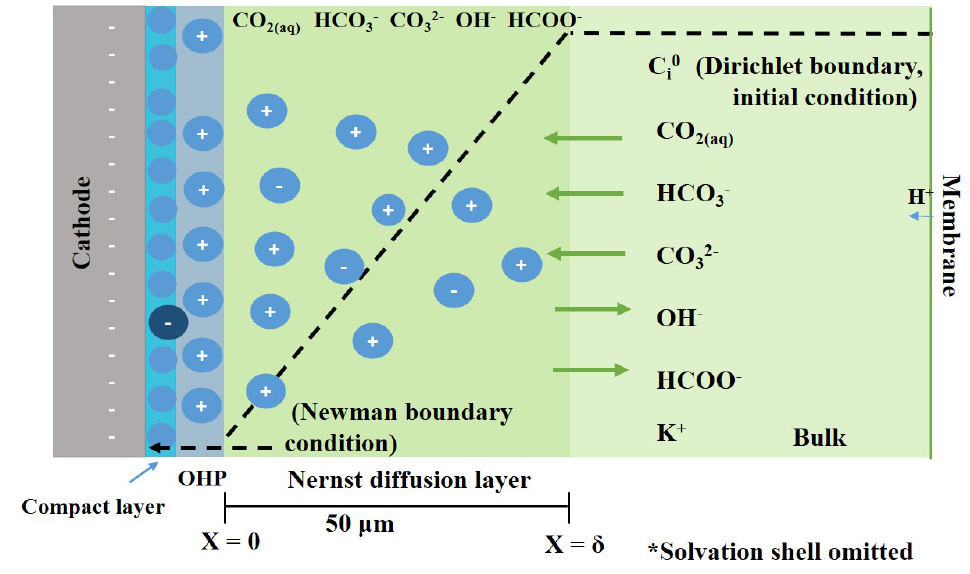
Figure 2. Schematic representation of the cathode diffusion–reaction model. It consists of a bulk electrolyte, diffusion layer and electrode surface. The diffusion layer contains two boundaries, one at the bulk of the electrolyte, and another one at the electrode surface. The dotted line indicates the concentration profile of the species inside the Nernst diffusion layer. The diffusion of ions in and out of the diffusion layer is represented by arrows. The solvation shell is omitted. OHP denotes the outer Helmholtz